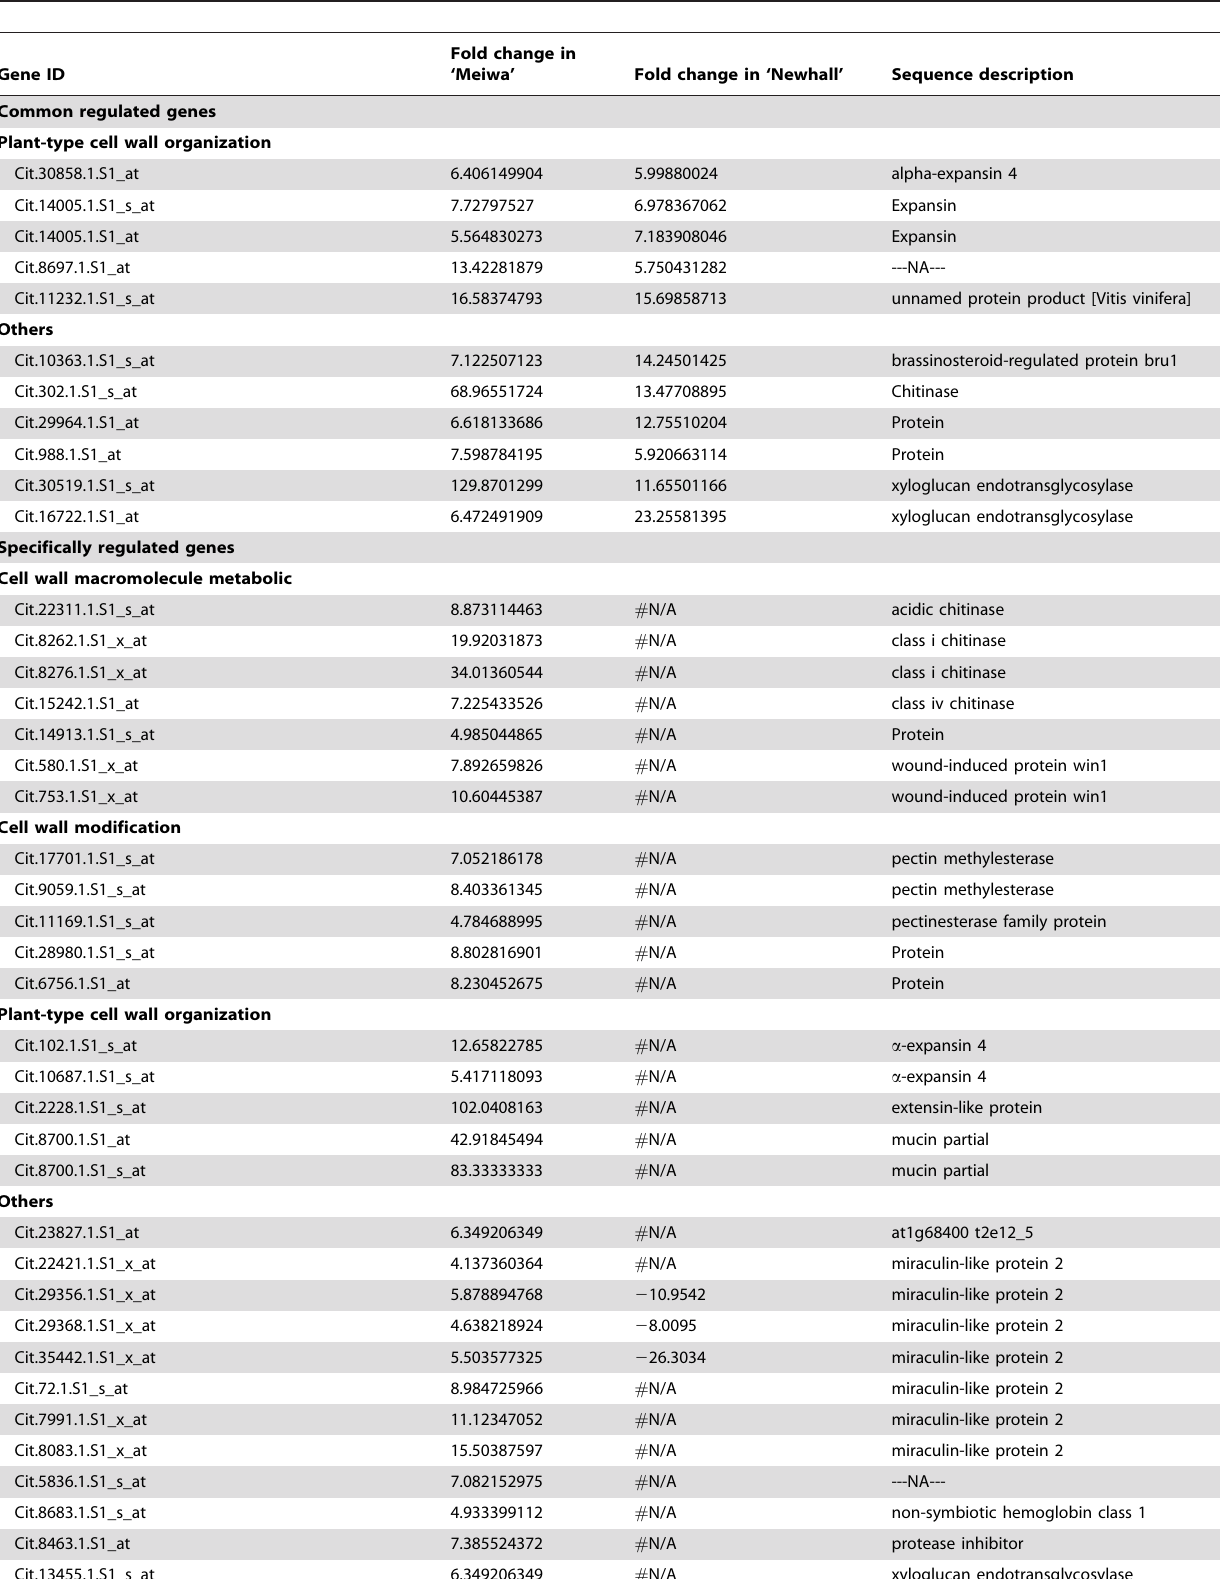
Table 4. Significantly enriched cell wall-related genes that are regulated in common between ‘Meiwa’ and ‘Newhall’ or specifically regulated in